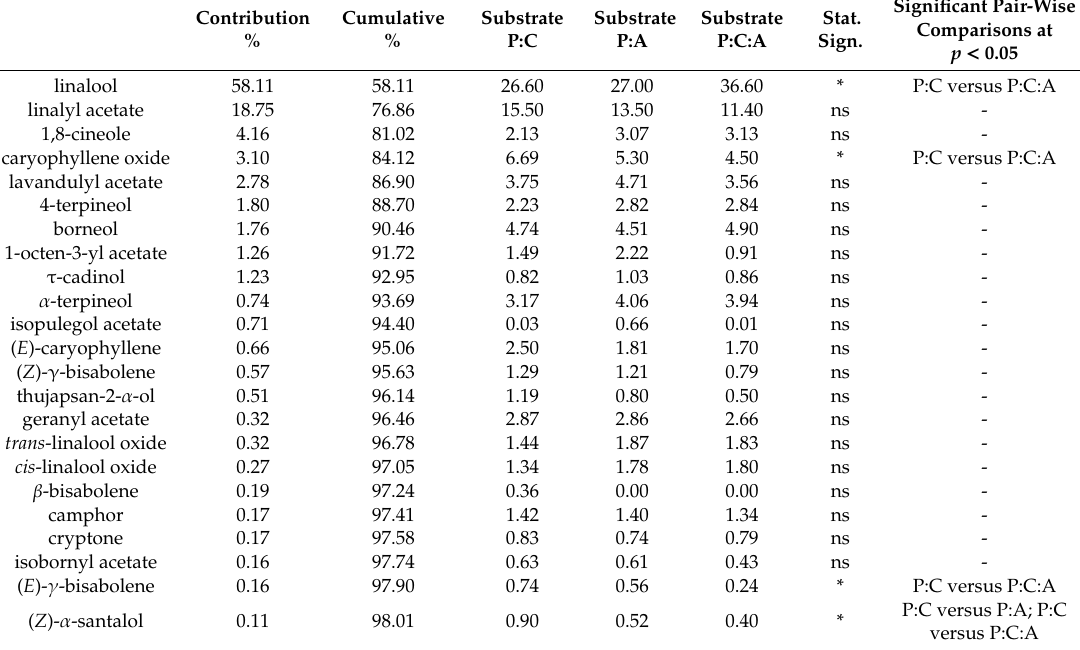
Table 6. List of compounds responsible for dissimilarity in lavender EOs induced by substrate (P:C = peat and green compost, 70%:30% v / v ; P:A = peat and demolition aggregates, 70%:30% v / v ; P:C:A = peat, green compost and demolition aggregates, 40%:30%:30% v / v ), according to the similarity percentage (SIMPER) analysis.